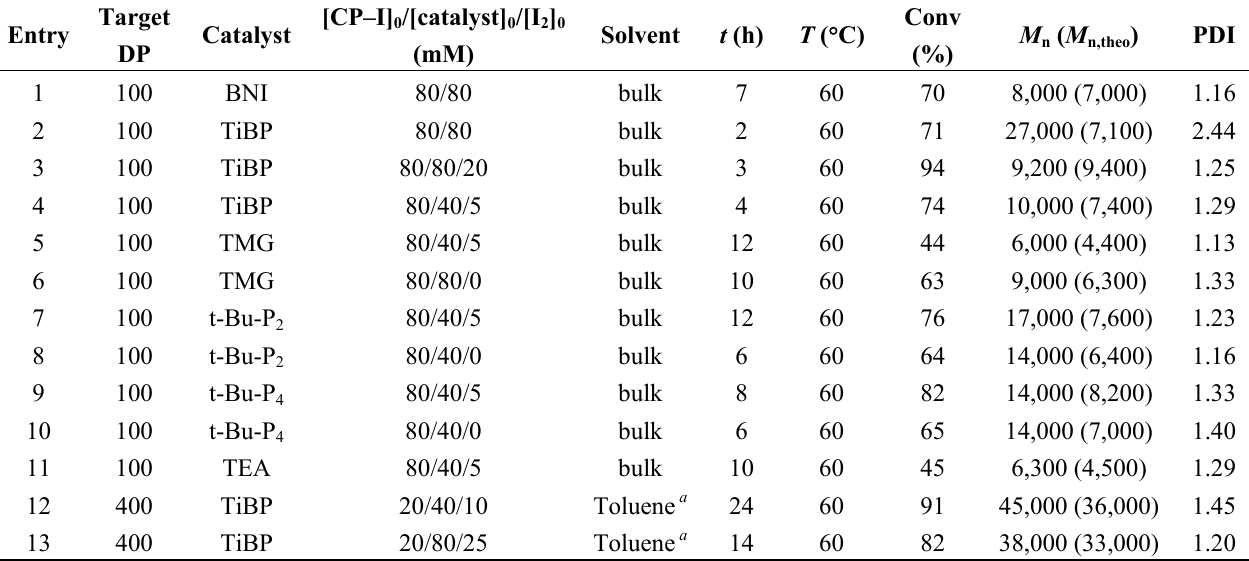
Table 1. Polymerizations of methyl methacrylate